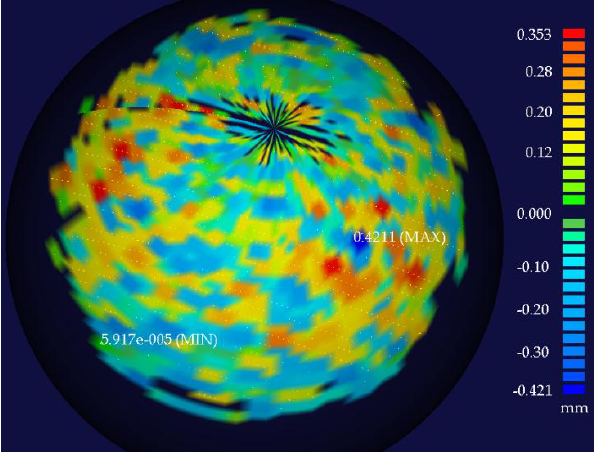
Figure 10. The error distribution between the fitted sphere and the scatter points measured at Position 6.